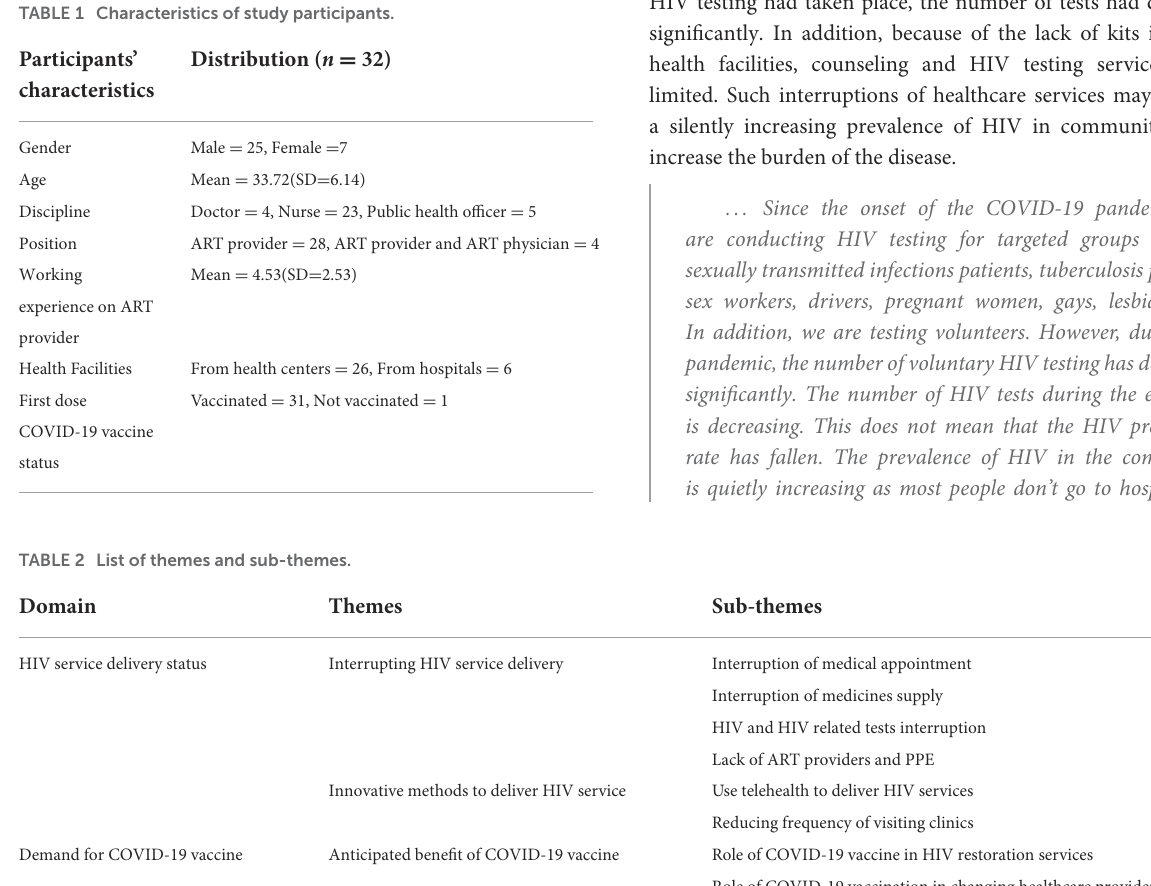
TABLE 1 Characteristics of study participants.